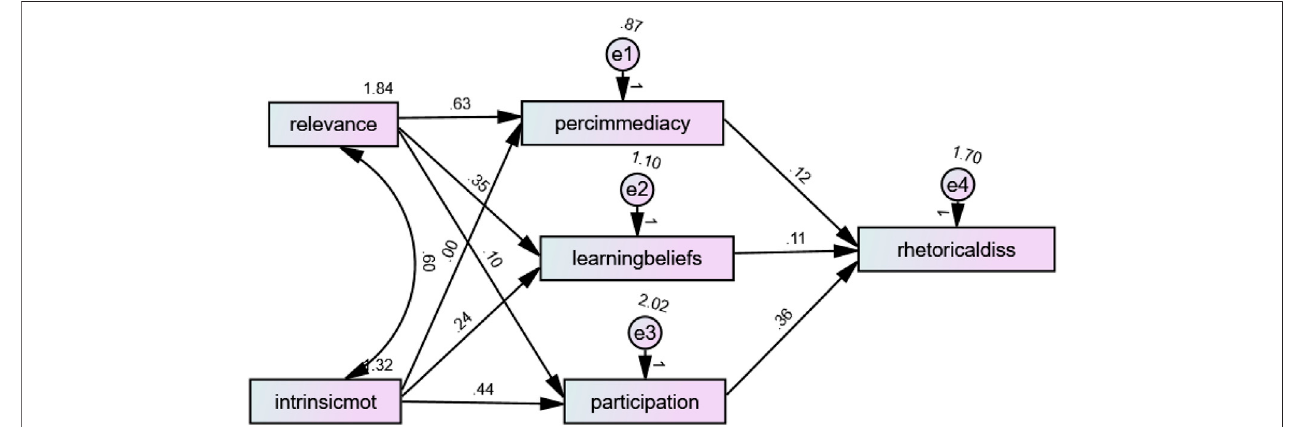
FIGURE 5 | Rhetorical dissent without class preference (Supported model).